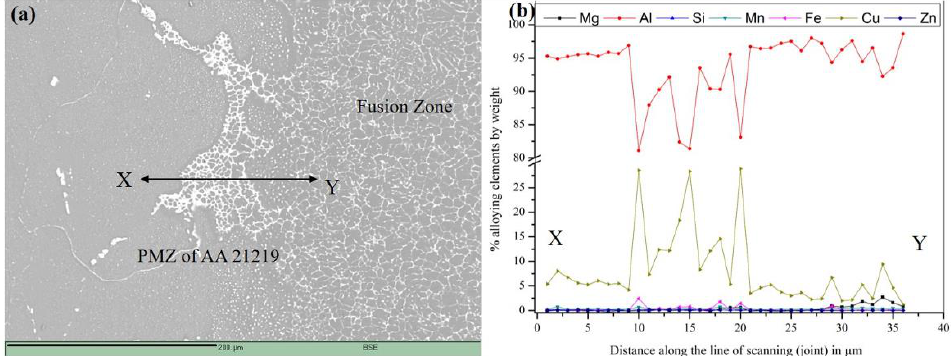
Figure 13. EPMA across PMZ towards AA 2219 Al alloy side. ( a ) BSE microstructure; ( b ) elemental distribution.